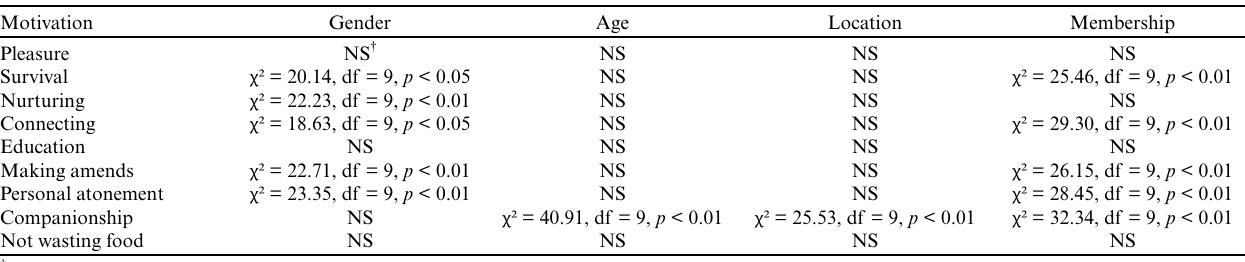
Table 2 . Summary of Chi-squared tests comparing frequency distributions of support for the 10 Likert scale levels for gender (male vs female), age (< 50 years vs > 50 years), location (London vs non-London), and memberships status (member vs nonmember) in explaining the motivations of the public feeding birds in south-east England in 2012.